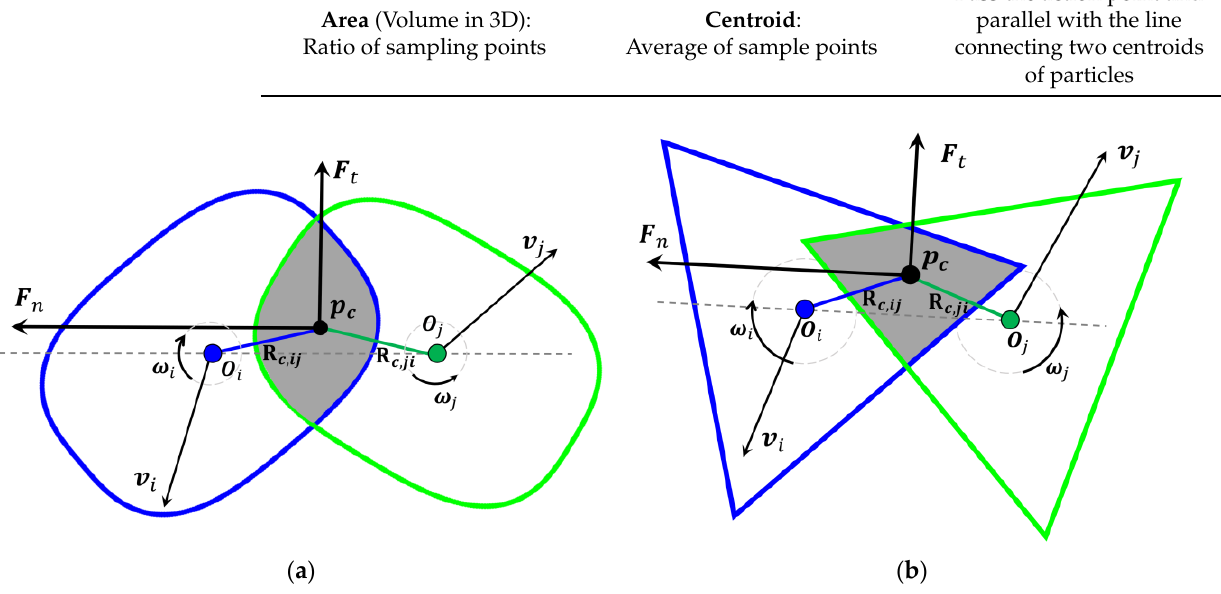
Figure 1. Contact model of non-circular particles: ( a ) Super-ellipse a / b = 1.5, m = 1.5; ( b ) Regular triangle.